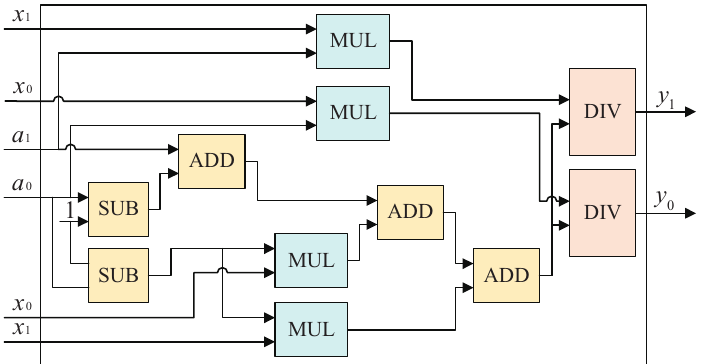
Figure 6. Hardware structure for calculating y 0 and y 1